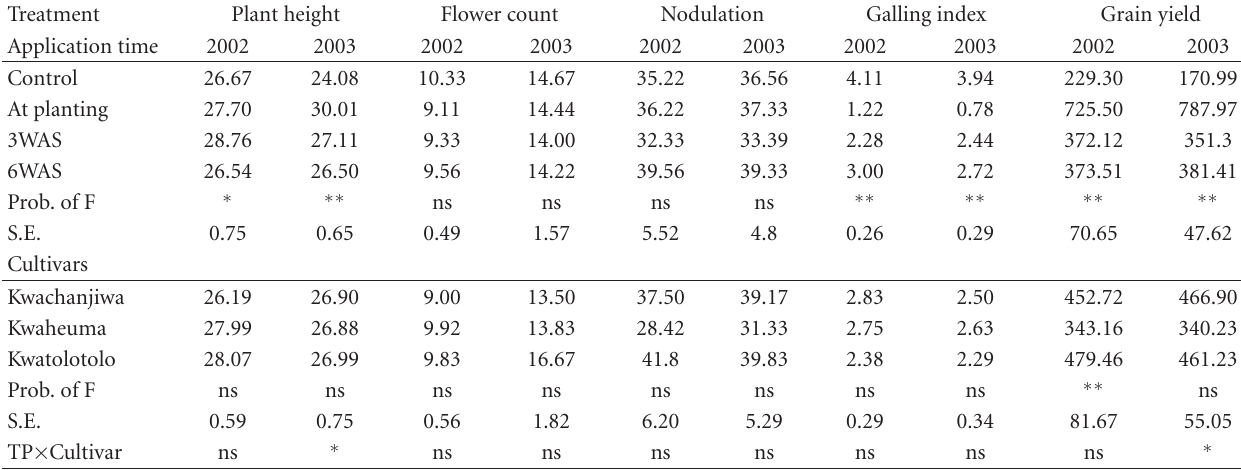
Table 3: E ff ects of application of carbofuran to control M. javanica on the performance of bambara groundnut taken in 2002 and 2003 cropping